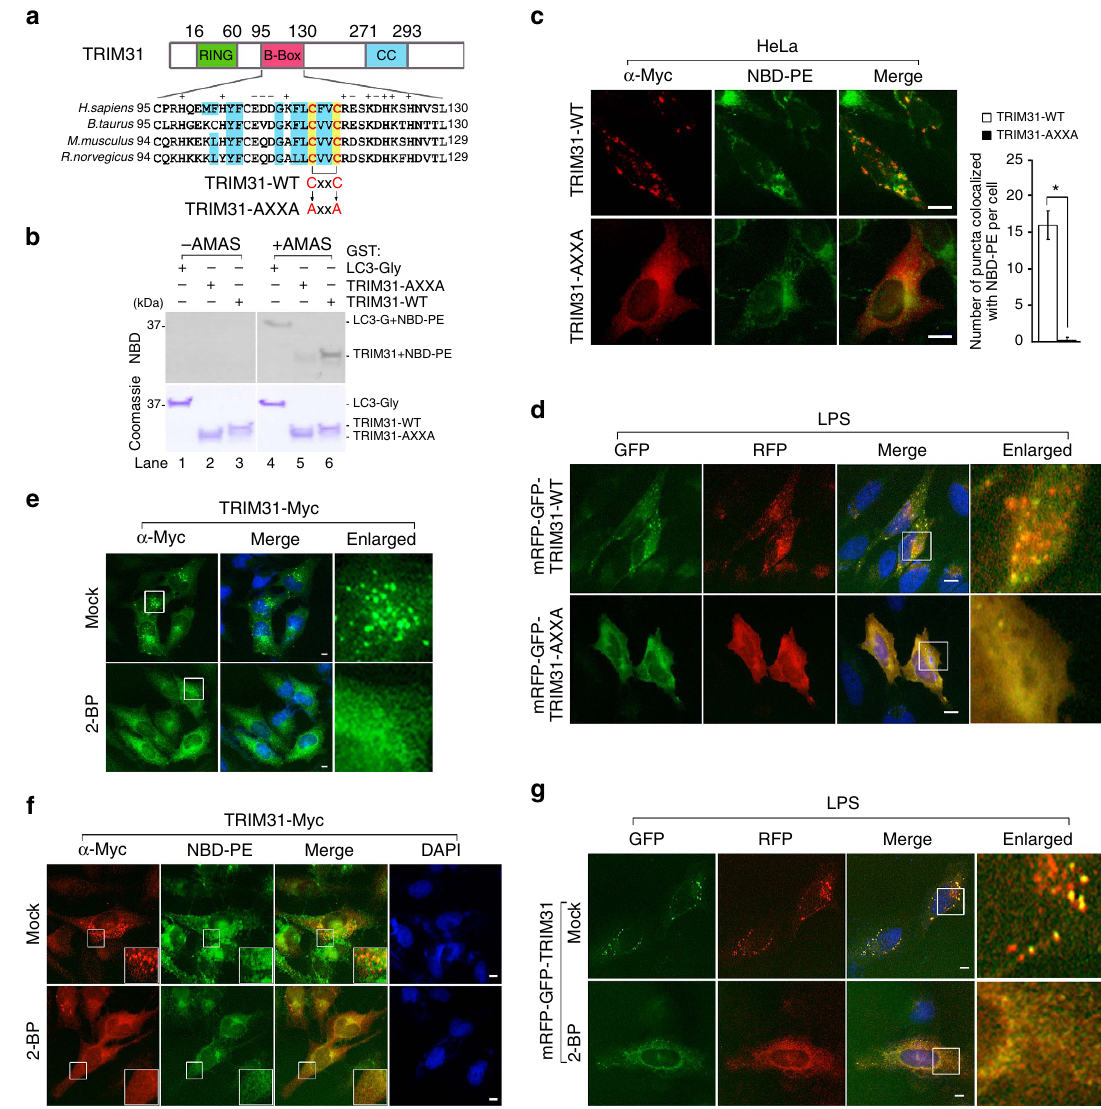
Figure 5 | TRIM31 interacts with PE in a palmitoyl-dependent manner. ( a ) Multiple sequence alignment of the B-box domain containing a predicted palmitoylation site composed of the conserved CXXC motif. The wild-type TRIM31 CXXC motif (TRIM31-WT) was mutated to AXXA (TRIM31-AXXA). Blue box, conserved hydrophobic amino acids; yellow box, conserved cysteine residues. The RING, B-box and coiled-coil domains are depicted in green, pink and blue, respectively. ( b ) Crosslinking experiment of GST-tagged recombinant proteins with 80% 18:1–16:0 PC and 20% 18:1–12:0 NBD–PE liposomes. GST-TRIM31-wild-type B-Box (GST-TRIM31-WT), GST-TRIM31-AXXA-mutated B-Box (GST-TRIM31-AXXA), or GST-glycine-exposed LC3 (GST-LC3-Gly) was incubated with liposomes, and then samples were analysed by SDS–PAGE. The LAS image analyser was used to detect NBD fluorescence (upper) while Coomassie blue staining was used to visualize protein levels (bottom). GST-LC3-Gly was used as a positive control. ( c ) Colocalization of wild-type (TRIM31-WT) or AXXA-mutated TRIM31-Myc (TRIM31-AXXA) with NBD–PE. HeLa cells were transfected with TRIM31-WT-Myc or TRIM31-AXXA-Myc, labelled with NBD–PE liposomes for 1h, washed twice with PBS, and incubated for 1h in complete media. Scale bars, 5 m m. Quantification is shown in the right graph (mean ± s.d.). * P o 0.01 (Student’s t -test). ( d ) HeLa cells expressing mRFP-GFP-tagged wild-type TRIM31 (mRFP-GFP-TRIM31-WT) or AXXA- mutated TRIM31 (mRFP-GFP-TRIM31-AXXA) were treated with LPS (100ngml (cid:2) 1 ) for 4h. Scale bar, 5 m m. ( e ) Palmitoylation is involved in forming a punctate structure of TRIM31. HeLa cells stably expressing TRIM31-Myc were left untreated or treated with 2-BP (20 m M) for 12h. TRIM31-Myc was stained using anti-Myc antibody and analysed by IFA. Blue, DAPI. Scale bar, 5 m m. ( f ) Palmitoylation is essential for TRIM31–PE interaction. HeLa cells expressing TRIM31-Myc were left untreated or treated with 2-BP (20 m M) for 12h and then labelled with 20% NBD–PE/80% POPC liposomes. TRIM31- Myc was immunostained with anti-Myc antibody and analysed by IFA. Blue, DAPI. Scale bar, 5 m m. ( g ) HeLa cells expressing mRFP-GFP-TRIM31 were incubated for 9h in 2-BP (25 m M) and then stimulated with LPS (100ngml (cid:2) 1 ) for 3h. Scale bar, 5 m m. All data are representative of at least two independent wild-type TRIM31, the expression of TRIM31-AXXA failed to detect a significant induction of LC3-II accumulation in HEK293T and HeLa cells (Supplementary Fig. 8c,d). Further- more, we did not observe RFP signals from TRIM31-AXXA, indicating that these cysteine residues are critical to the induction